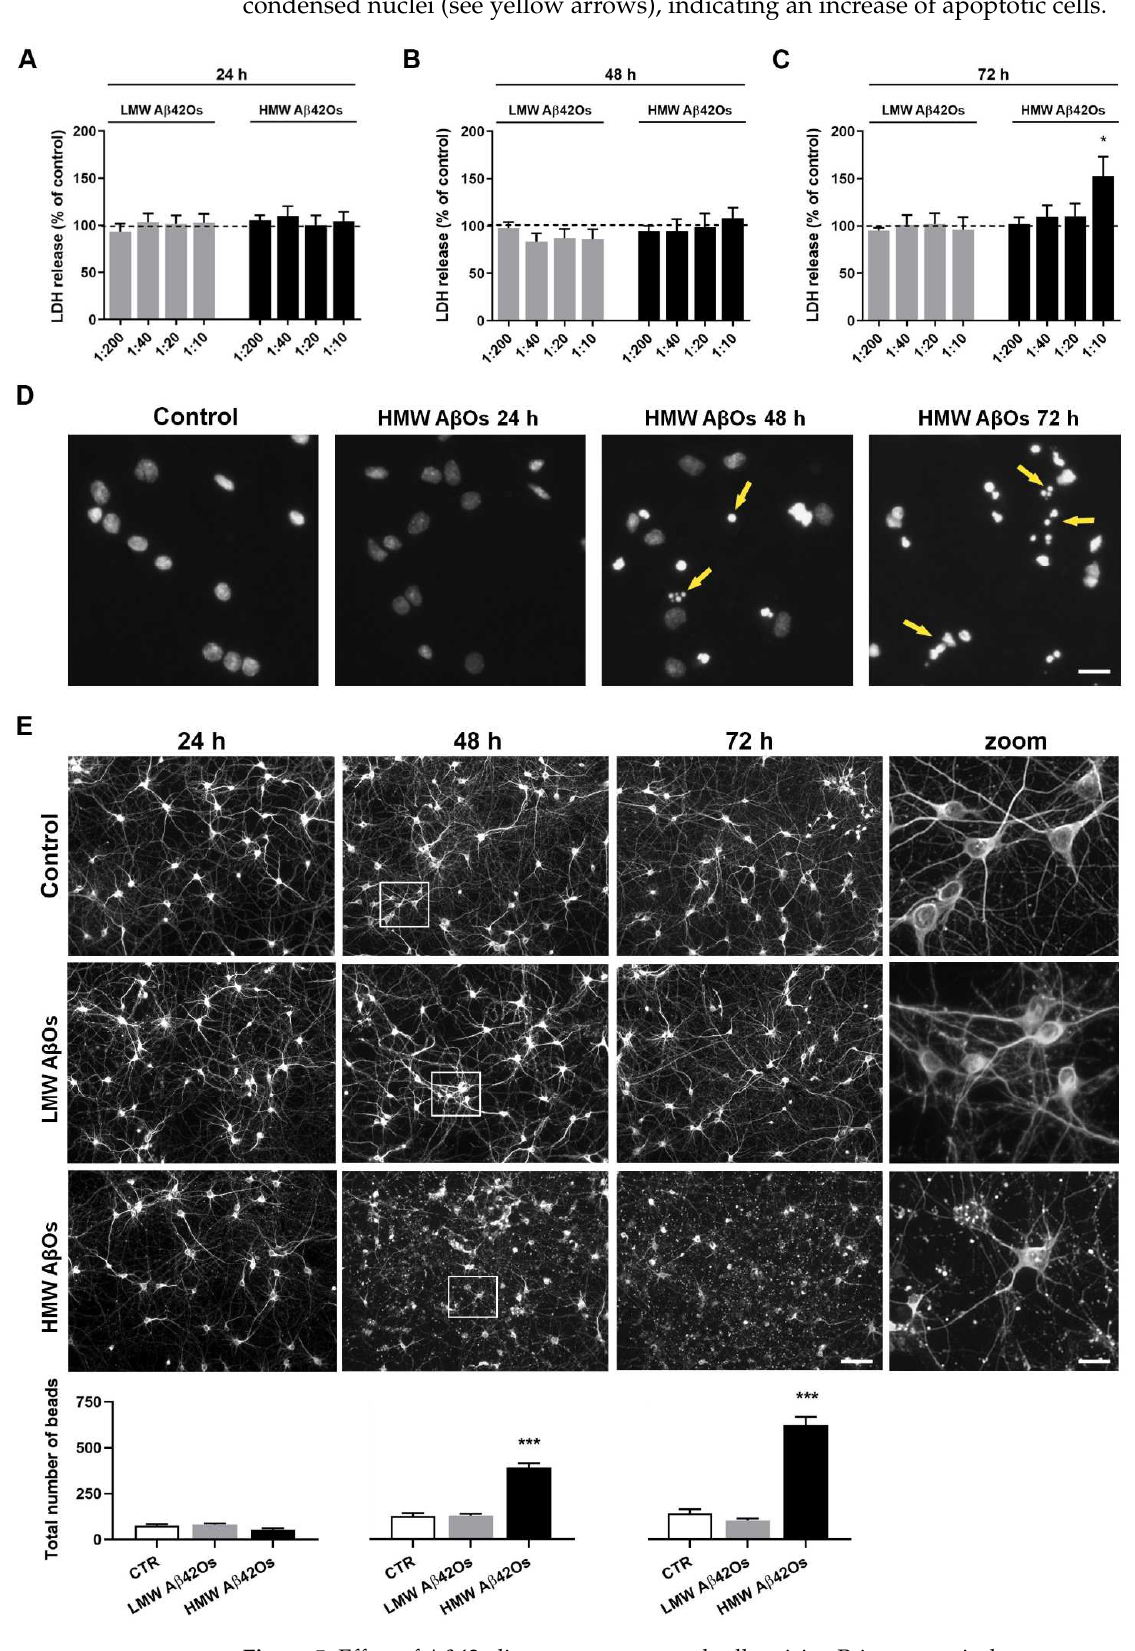
Figure 5. Effect of A β 42 oligomers on neuronal cell toxicity. Primary cortical neurons were